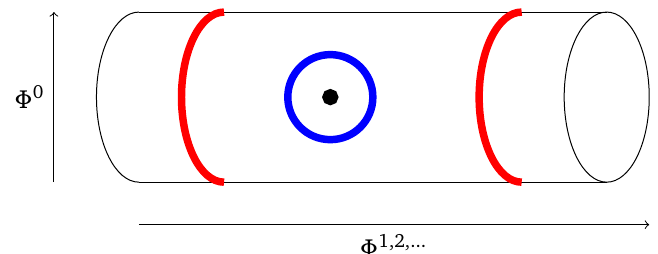
Figure 1: The 5-cycles S 5 (in blue) and S 4 × S 1 (in red) are homologous in (cid:82) 5 × S 1 , the space where the scalar fields Φ I , I = 0...5 are valued. This is equivalent to the statement that the flux through the boundary at infinity is preserved when the radius of S 1 is taken to be infinitely